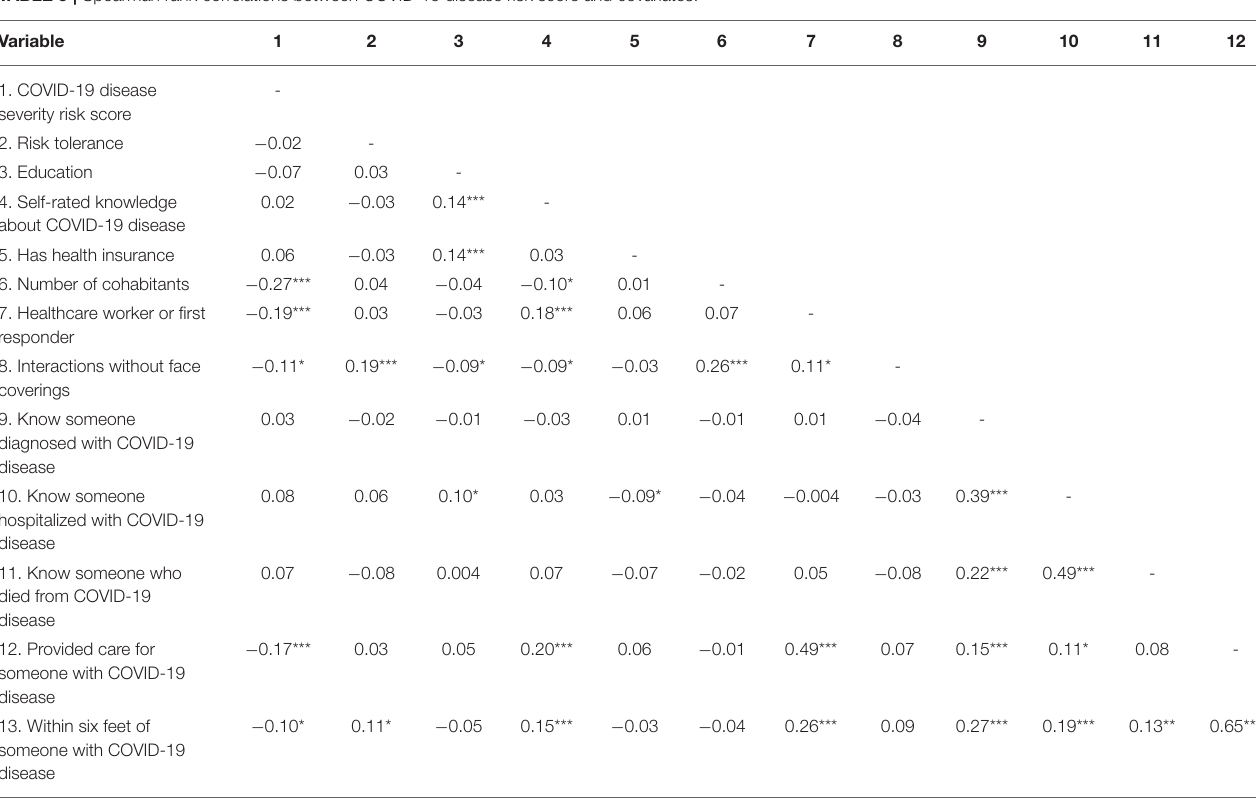
TABLE 5 | Spearman rank correlations between COVID-19 disease risk score and covariates.